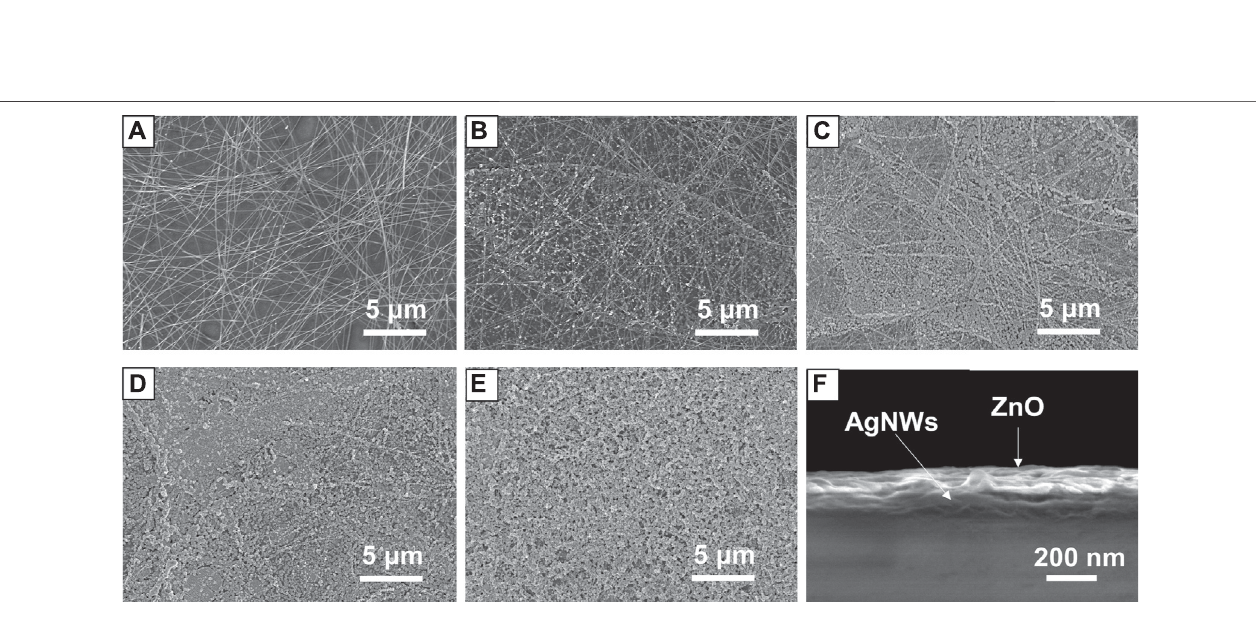
Frontiers in Chemistry |